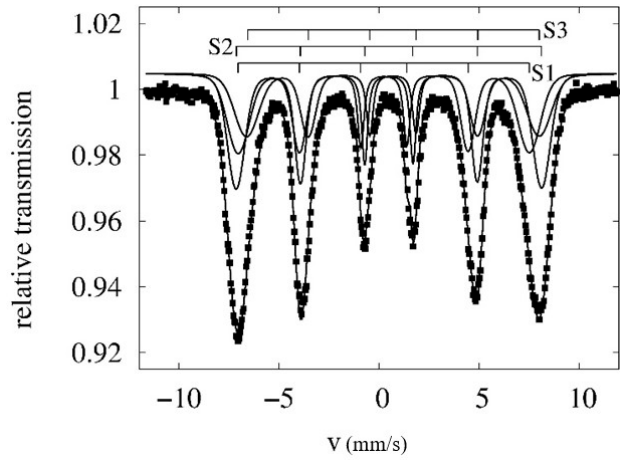
Figure 10. Room temperature (RT) Mössbauer MS spectrum of the EC solid product prepared from leachate of EAFS.